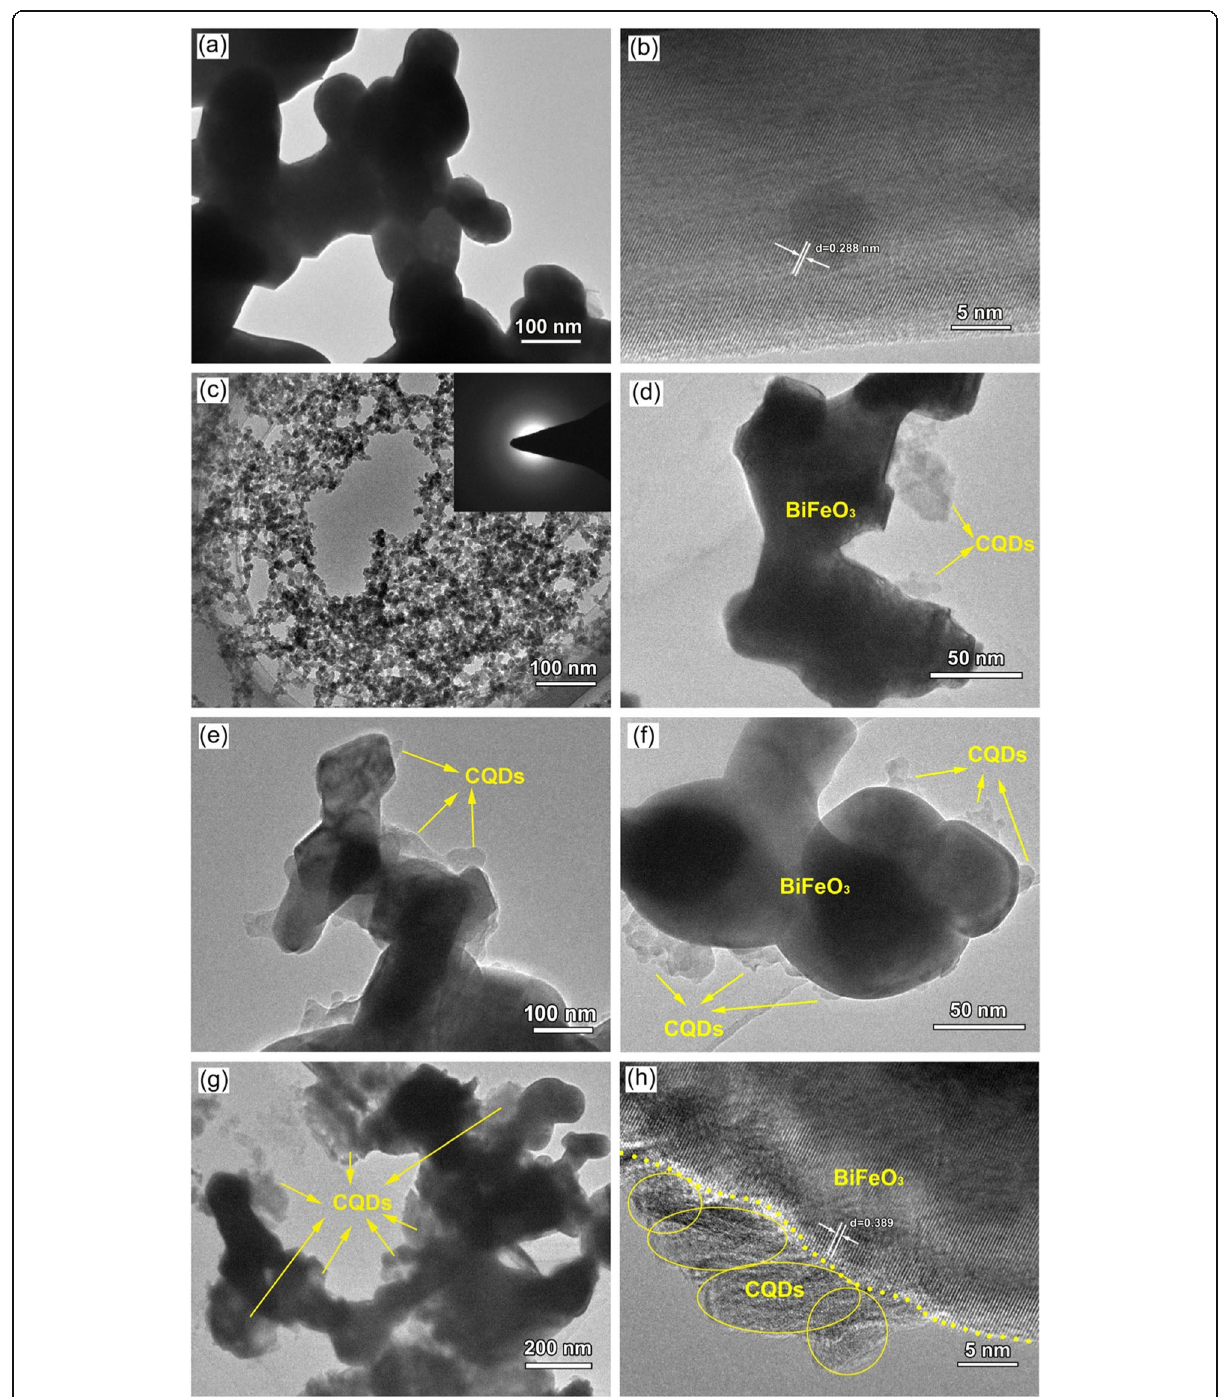
Fig. 6 a and b TEM and HRTEM images of bare BiFeO 3 nanoparticles, respectively; c TEM image of CQDs; d – g TEM images of 3C/BFO, 6C/BFO 12C/BFO, and 24C/BFO respectively; h HRTEM image of